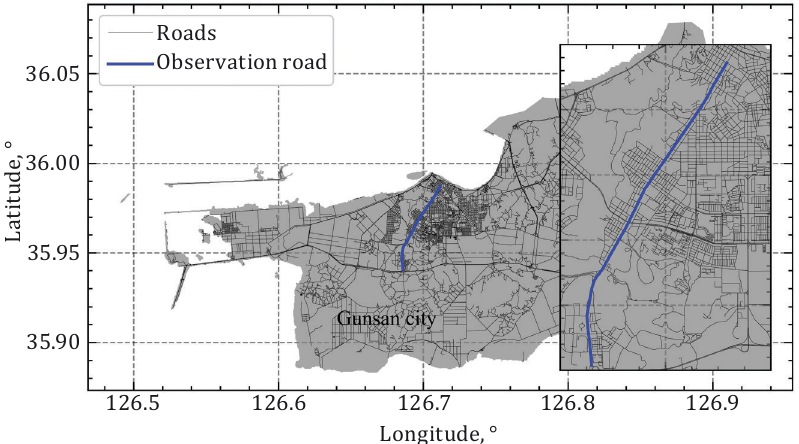
Figure 10. A 5-km observation road in Gunsan city Longitude,